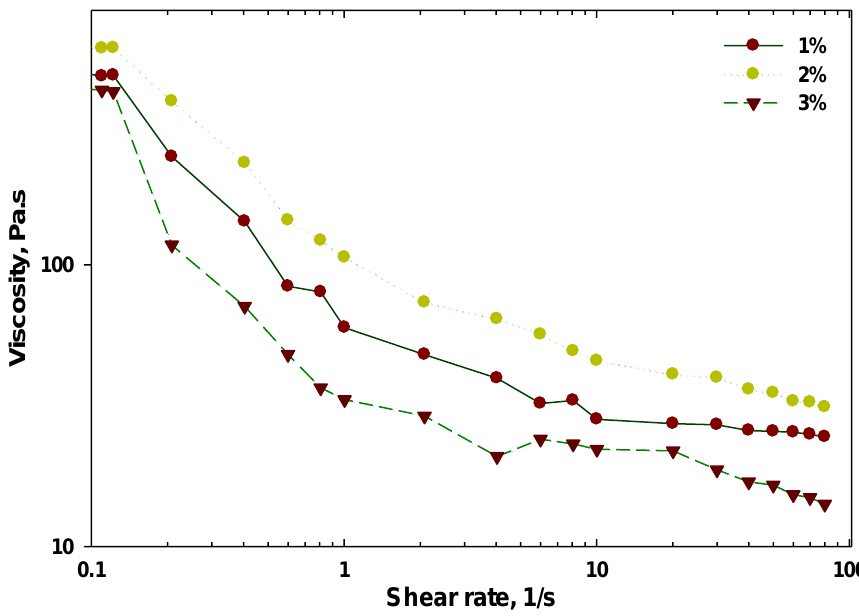
Figure 1. Effect of SISH concentration on the apparent viscosity of SISH dispersions as a function of shear rate from 0.1 to 100 s − 1 at 20 °C.